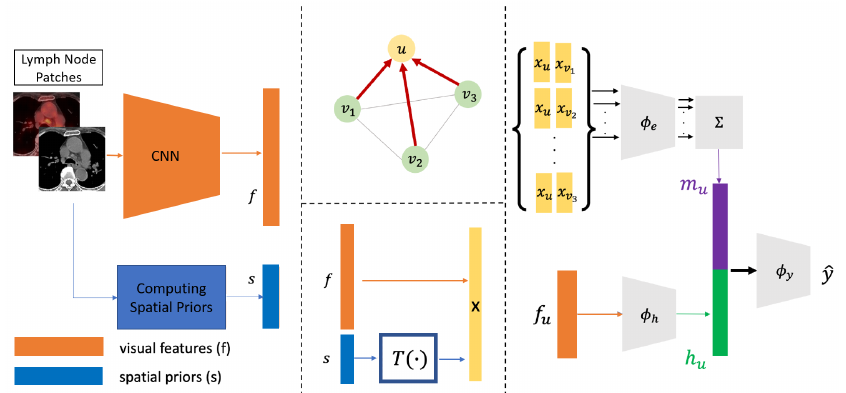
Figure 14. To construct the node representation, the model extracts CNN appearance features and spatial priors for each candidate. Each GTV candidate corresponds to a node in the graph and the GCN is used to exchange information. Image adapted from